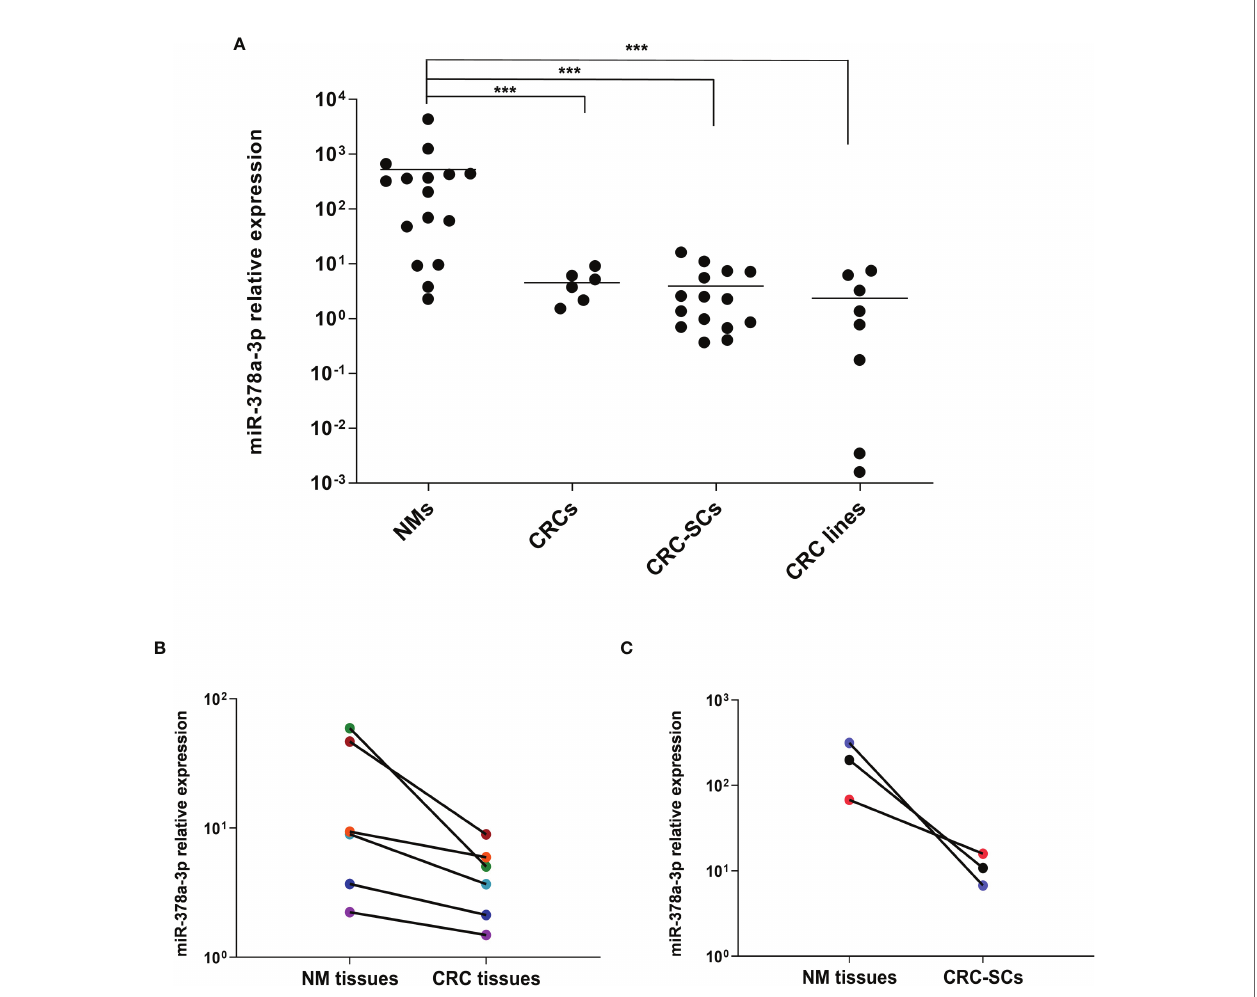
FIGURE 1 | miR-378a-3p is low expressed in CRC tissues, patient-derived CRC SCs and CRC cell lines. (A) MiR-378a-3p expression was analyzed by qRT-PCR in normal mucosal tissues (NMs, n=16), CRC tissues (CRCs, n=6), CRC-SCs (n=15) and CRC cell lines (n=8). Samples were run in duplicate. Data were normalized to the small nuclear RNA RNU6B expression in the corresponding samples. ***, p<0.001 based on Mann-Whitney test. (B) qRT-PCR analysis of miR-378a-3p expression in 6 matched pairs of CRC tissues and normal mucosal tissues derived from the same patient (same color points). (C) qRT-PCR analysis of miR-378a-3p expression in 3 matched pairs of CRC-SC lines and normal mucosal tissues derived from the same patient (same color points). Samples were run in duplicate. Data were normalized to the small nuclear RNA RNU6B expression in the corresponding